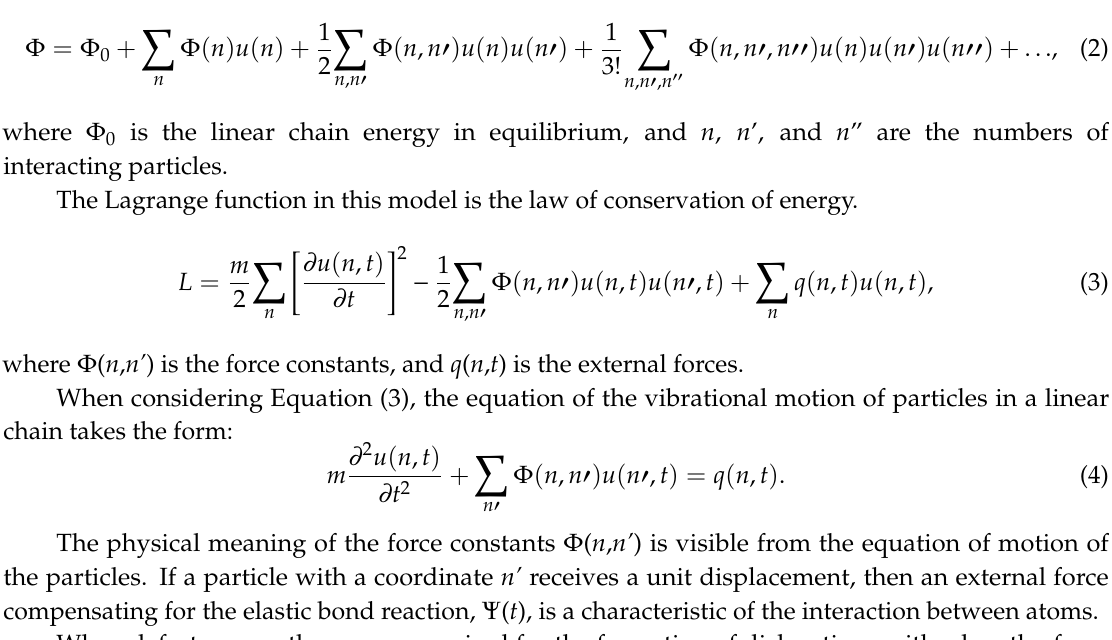
Figure 18. The propagation of a longitudinal disturbance in a chain of atoms.